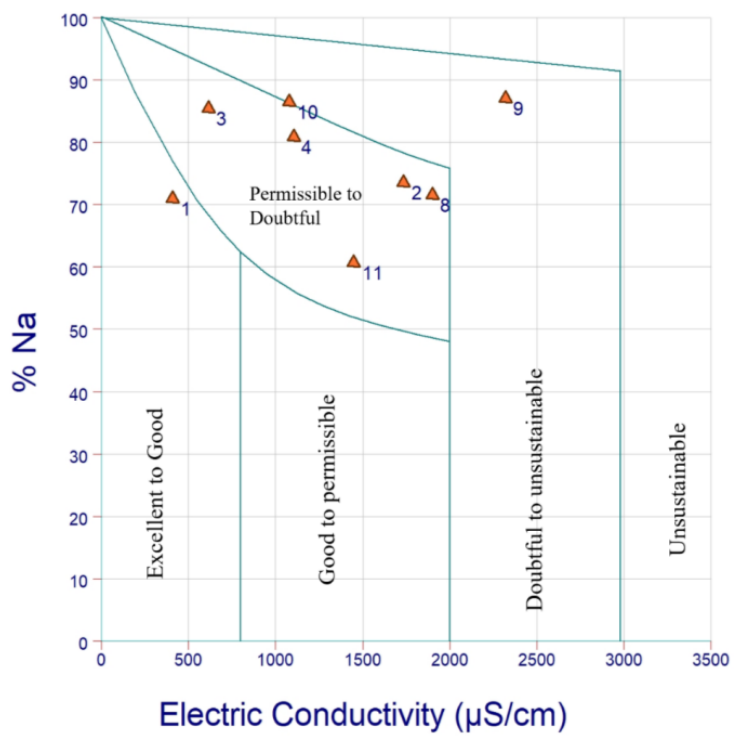
Figure 6. Classification of groundwater samples in relation to salinity and sodium hazards [96].